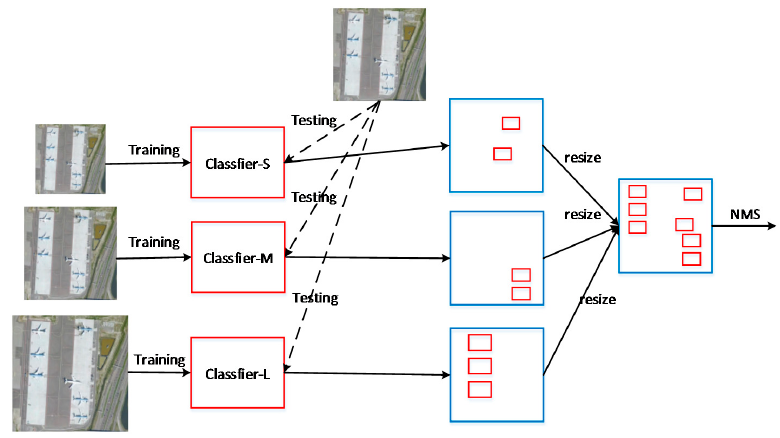
Figure 14. Strategy of the multi-scale training. Table 8. The AP values of the object detection strategies.